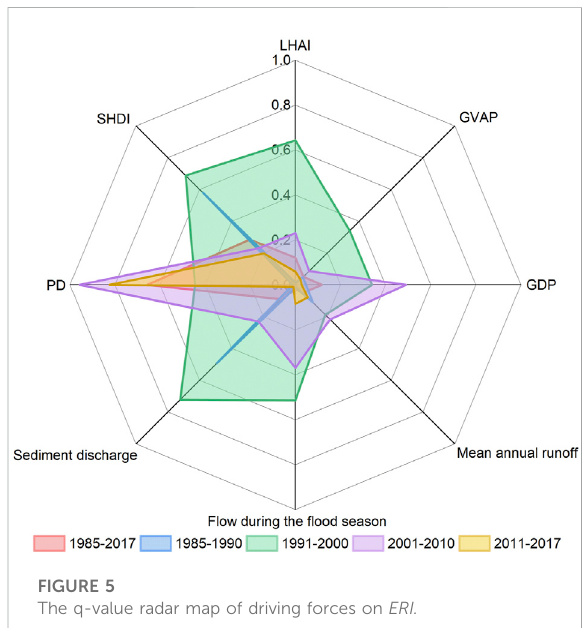
FIGURE 5 The q-value radar map of driving forces on